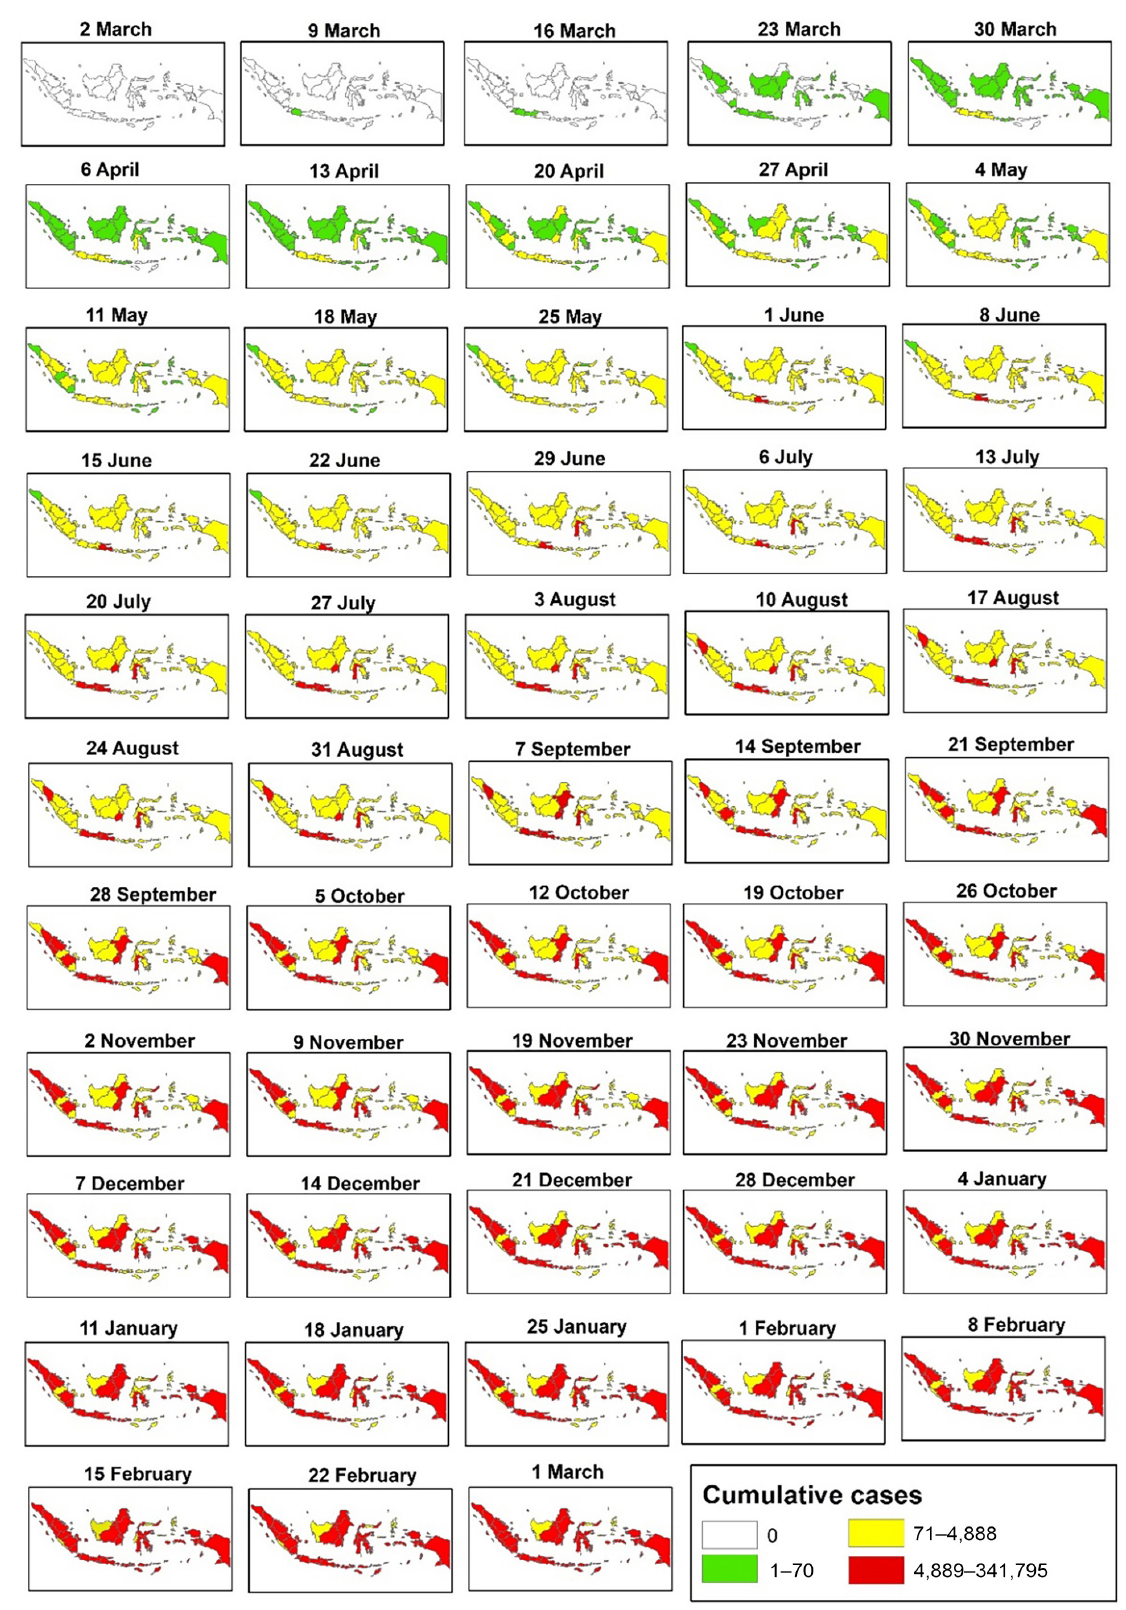
Fig. 3. COVID-19 cases between March 2020 and March 2021. Source: own